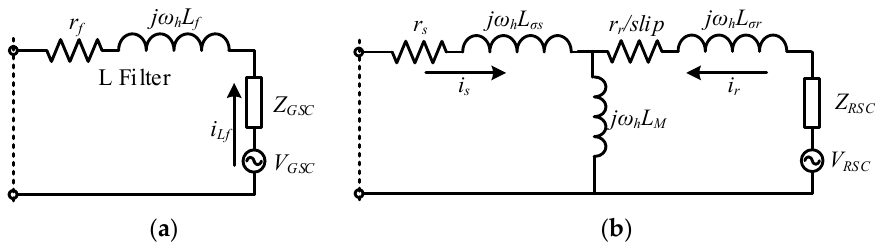
Figure 3. Single phase equivalent circuit of a doubly fed induction generator (DFIG). ( a ) Grid side converter (GSC) impedance modeling, ( b ) DFIG machine and rotor side converter (RSC) impedance modeling.